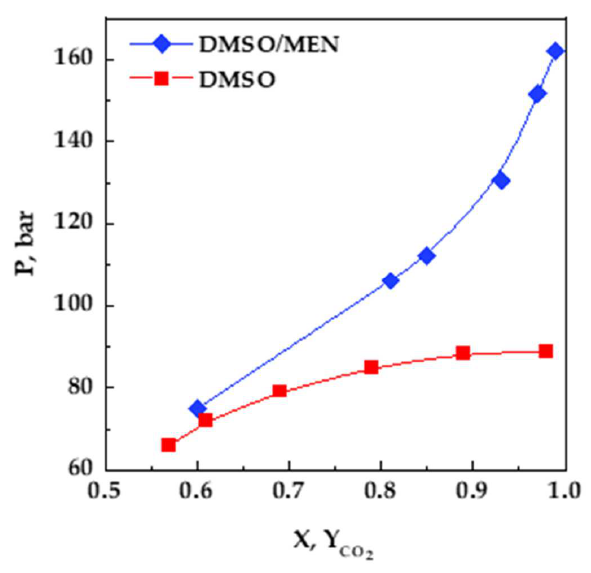
Figure 3. Comparison in a P-x diagram between DMSO/CO 2 /MEN system and pure DMSO at a temperature of 313 K.